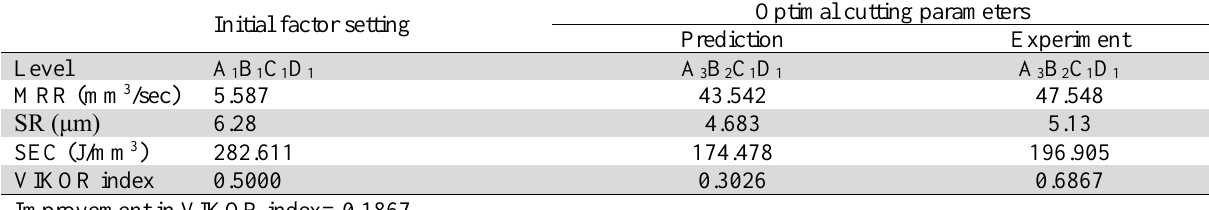
Results of the confirmatory experiment for VIKOR method Initial factor